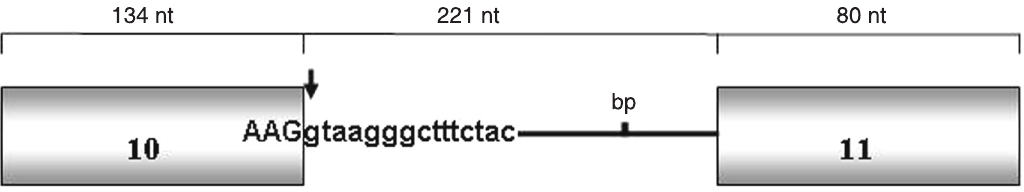
Figure 1. Rat AhR (intron 10 region) pre-mRNA constructs constructed for pre-mRNA splicing reactions in vitro. The arrow indicates the location of the point mutation detected in the H/W rat strain. AhR = aryl hydrocarbon receptor; bp = branch point nucleotide. Intron and exon sizes in nucleotides (nt) of constructs are